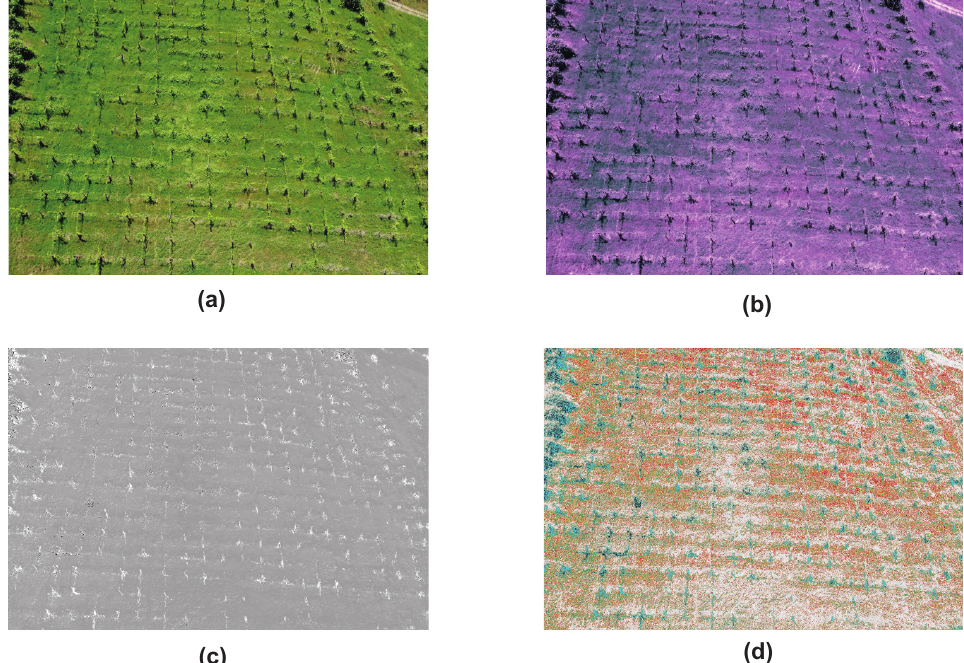
Figure 21. Site 2— NDVI analysis: original image ( a ), multi-spectral image ( b ), gray-scale image ( c ) and NDVI image ( d